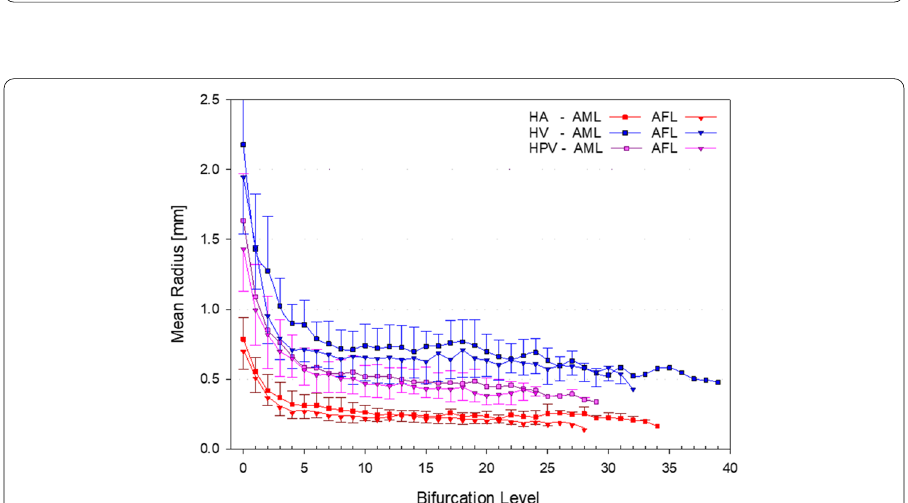
Fig. 5 Mean vessel radius per bifurcation level for each type of virtual vasculature created in the AML and AFL. Bars are the standard deviation associated with each mean